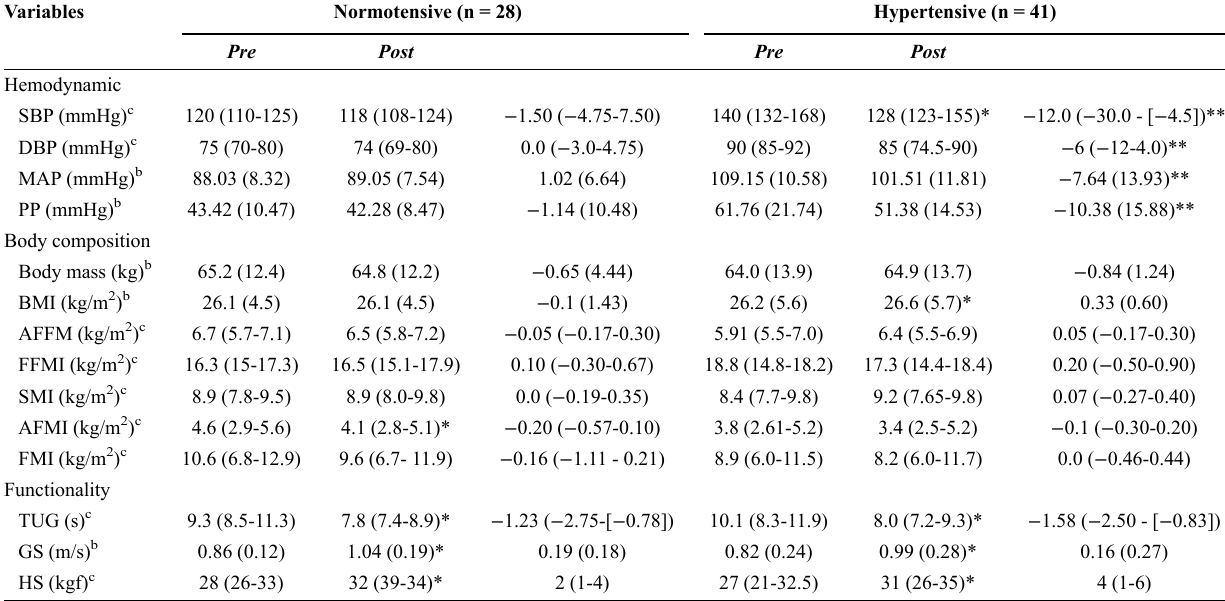
Table 2 - Effects of 12-week resistance training on study participants (n =